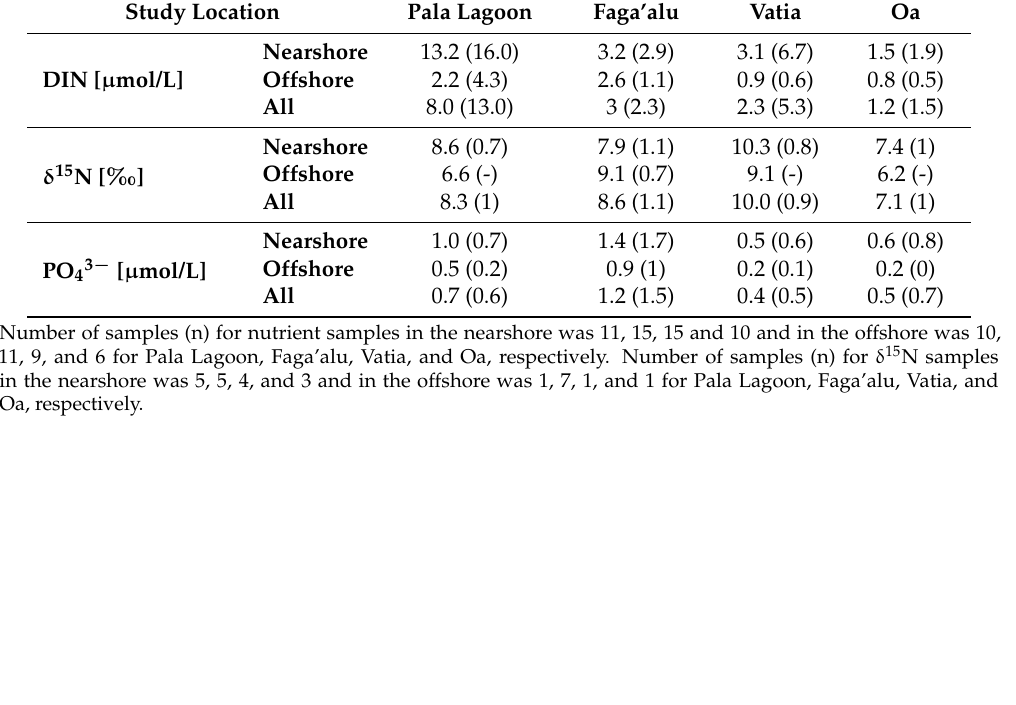
Table 2. Water quality parameters for coastal water samples showing nearshore vs. offshore gradients. Study